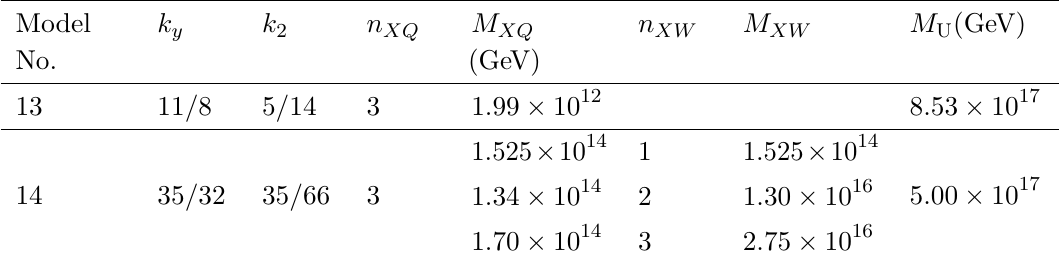
Table 5 . String-scale gauge coupling relations achieved by adding vector-like particles XQ + XQ from four-dimensional chiral sectors as well as XW from bb